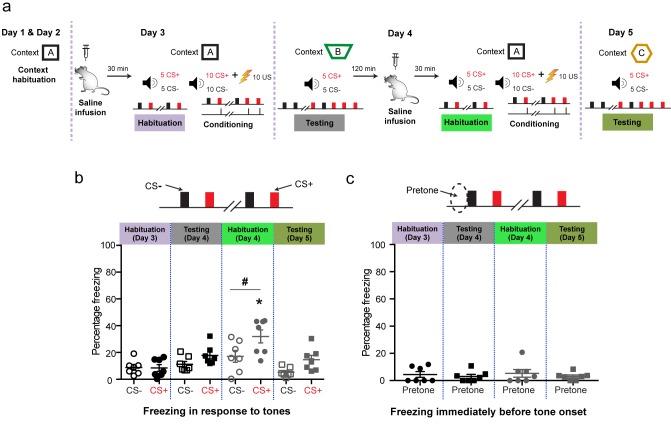
Control experiments using the same discriminative auditory fear conditioning with a weak US combined with in vivo infusion (1.0 µl per side) of saline (0.9% NaCl) followed by a second episode of the same saline infusion into the BLA of the same animal did not cause the increase in indiscriminate fear and cue-specific fear seen with DHPG infusion (as reported in Figure 2).‘Mean freezing levels 30 min after saline infusions on Day 3 showed no difference between the CS+ and CS− during habituation (N = 7 rats, p>0.05). During testing 1 d after weak conditioning (Day 4), the CS+ did not evoke higher freezing relative to either the CS− (p>0.05), or habituation (p>0.05). However, 30 min after the second saline infusion, the same animals exhibited significantly higher freezing specifically for CS+ and not for CS− (*p<0.05) when habituated in the same conditioning context. The freezing levels were specific to CS+ (Habituation, Day 4: #p<0.05). Subsequently, a second episode of conditioning in the same animals in the presence of saline using the same weak US (Day 4, 0.4 mA) did not affect fear memory. Thus, during testing 1 d after weak conditioning, the CS+ did not evoke higher freezing relative to the CS− (Testing, Day 5: #p<0.05), as well as CS+-evoked freezing 1 d after first weak conditioning in saline (Testing, Day 4: *p<0.05). (c) Mean freezing levels in the different spatial contexts immediately before the presentation of tones (pretone) during the same tests described in (b). There was no difference in pretone freezing to the context during any of the sessions (p>0.05). *p<0.05 between sessions in all graphs; #p<0.05 between CS+ and CS− within sessions in all graphs.’.DOI:
http://dx.doi.org/10.7554/eLife.25665.00610.7554/eLife.25665.007Figure 2—figure supplement 1—source data 1.Data for individual animals representing freezing response to CS+, CS- and pretone during the different phases of behaviour (Figure 2—figure supplement 1b and c).